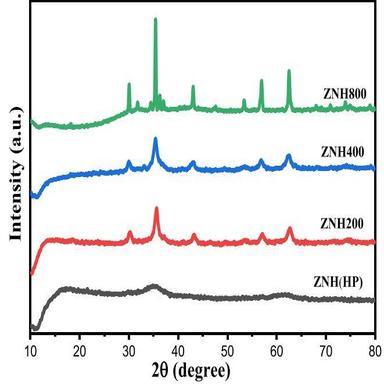
XRD patterns of the ZNF(HP) sample and ZNF(HP) sample annealed at 200, 400, and 800 °C.